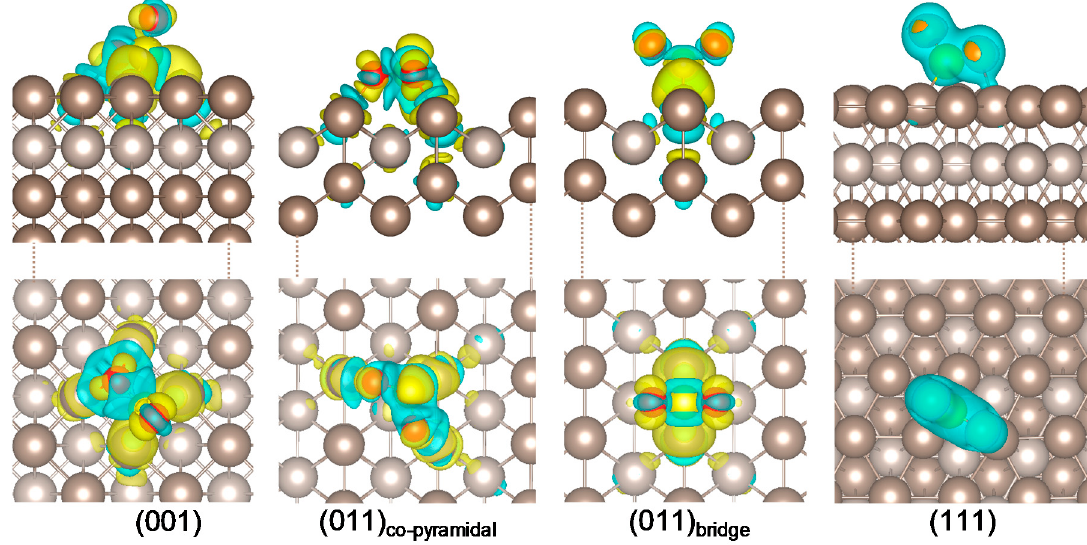
Figure 3. Iso-surfaces of the electron density difference between SO 2 and Pt (001), (011), and (111). Yellow and teal represent positive (electron gained) and negative (electron depleted) charge density with ± 0.0021, ± 0.0020, ± 0.0016, and ± 0.0300 e / Å 3 iso-surfaces, respectively.